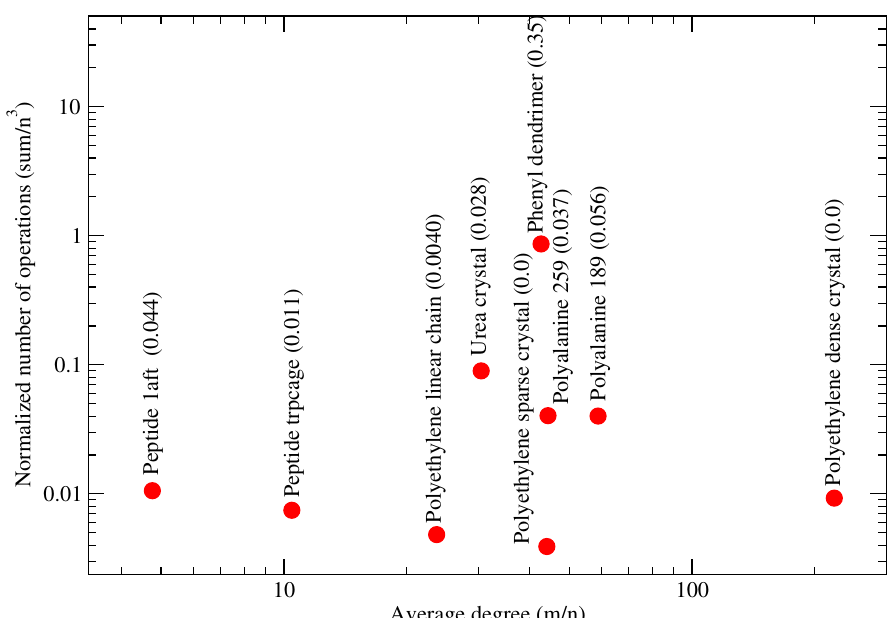
Figure 9. Sum of cubes criterion (3) normalized by the complexity n 3 of the dense matrix-matrix multiplication for G-SP2 with METIS. Number of vertices n , number of edges m , and average degree m / n . Test systems of Table 1. Brackets show fractions of ( max − min ) / n (MMPN). Figure taken from [12]. Copyright c (cid:13) 2016 Society for Industrial and Applied Mathematics. Reprinted